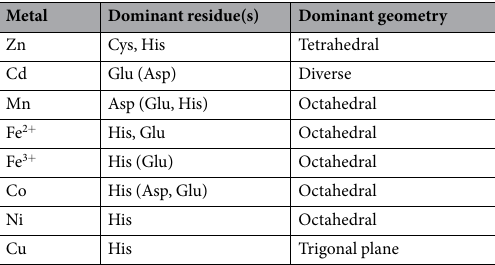
Table 1. The most abundant residues and coordination geometries (signature) of each metal. Residues in parentheses are highly represented but not the most abundant